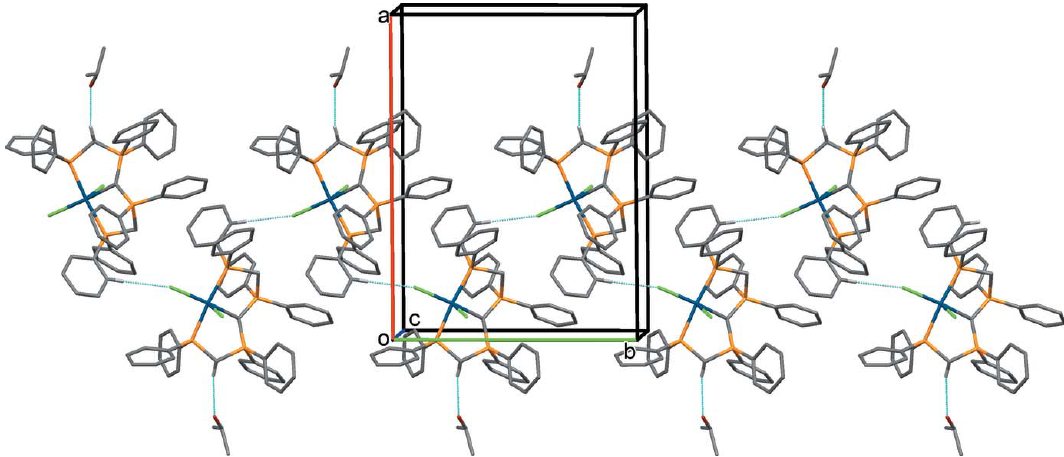
Figure 6 A view along the c axis of the crystal packing of compound 2 . Only the H atoms involved in the most significant intermolecular interactions (Table 3) have been included.